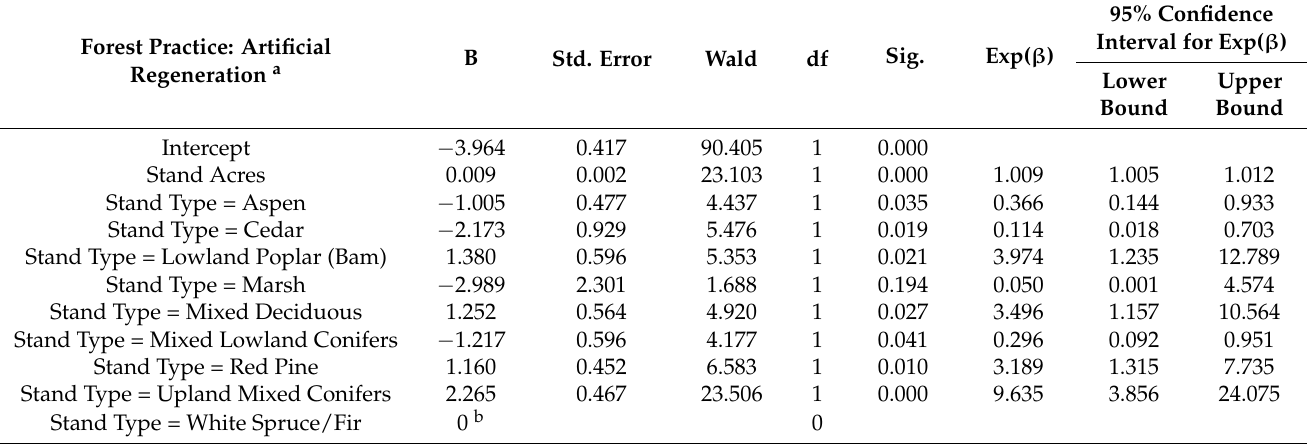
Table 2. Multinomial logistic regression parameter estimates for significant results predicting the forest practice “Artificial Regeneration.” Stand acres and stand type as independent variables (showing results from artificial regeneration). N = 20,915 unique forest stands enrolled in the Qualified Forest